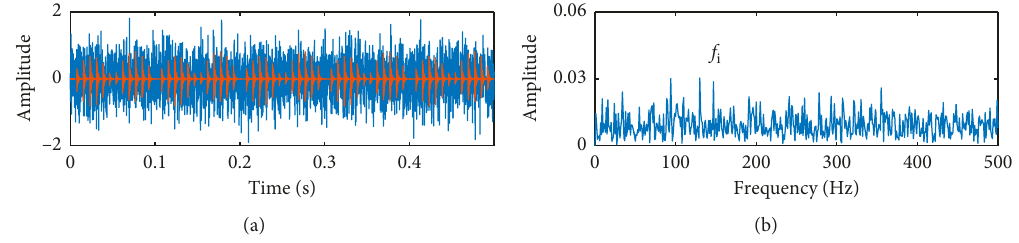
Figure 5: The simulation signal of inner ring defect: (a) TW; (b)